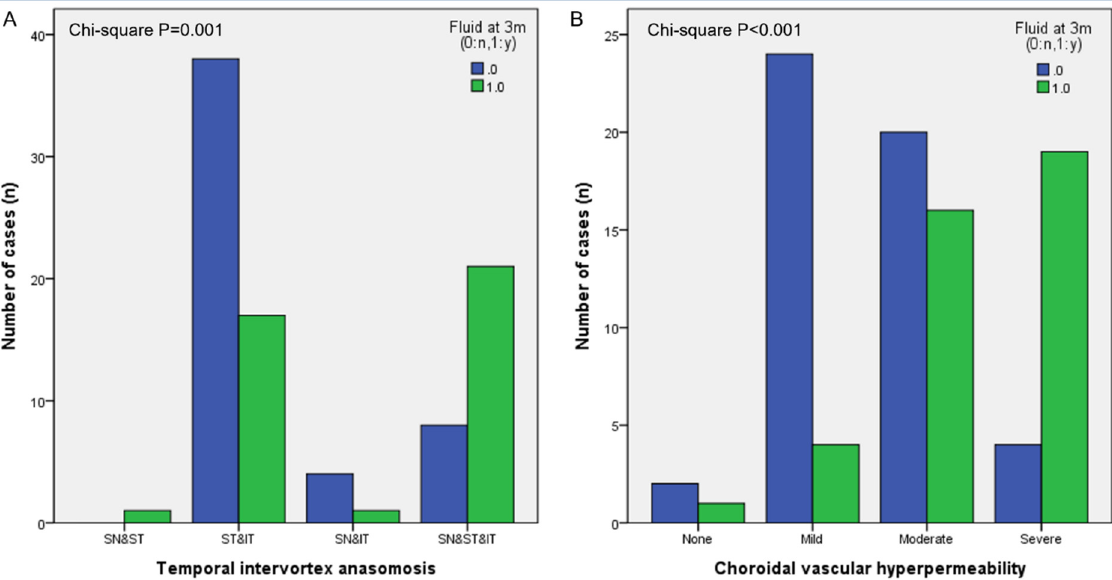
Figure 3. Analysis of temporal intervortex anastomosis and choroidal vascular hyperpermeability (CVH) grade on ultra-widefield indocyanine angiography images. ( A ) Superotemporal (ST) and inferotemporal (IT) vortex veins were the most common in intervortex anastomosis in the dry group, while anastomosis among three vortex veins, the superonasal (SN), ST and IT, was the most common in the non-dry group. ( B ) CVH grades differed between the dry and non-dry group. The mean CVH grade was 1.48 ± 0.735 in the dry group and 1.875 ± 0.822 in the non-dry group ( p = 0.020).